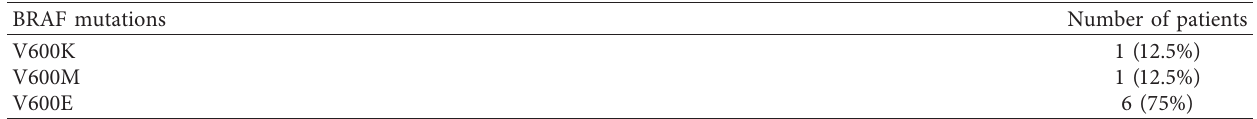
Table 4: BRAF mutations in melanoma